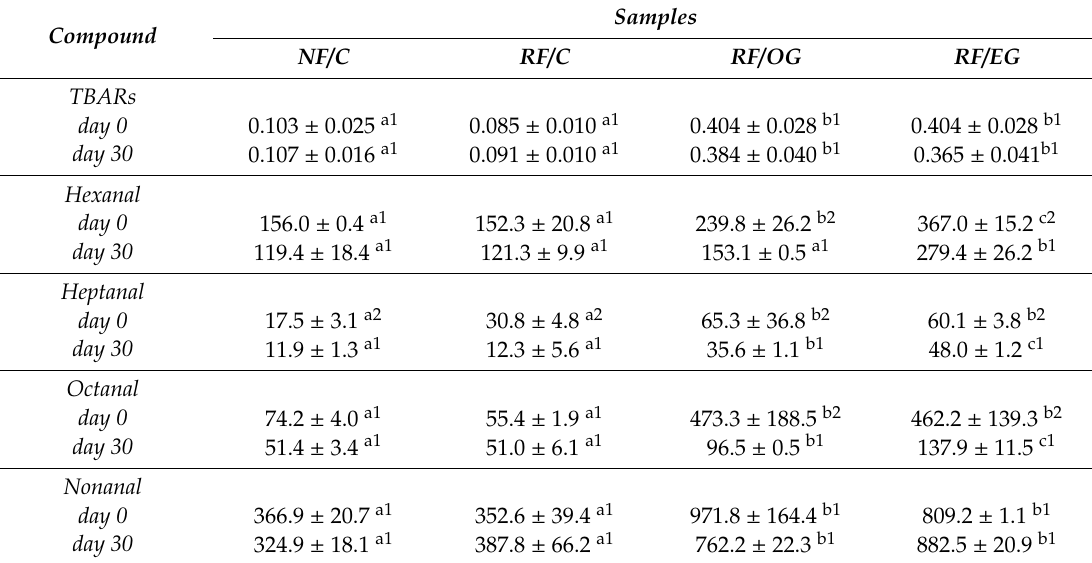
Table 5. Parameters related to lipid oxidation of fuets during chilled storage: thiobarbituric acid-reactive substances (TBARs) values (mg malonaldehyde (MDA) / kg sample) and volatile compounds (area / sample weight (g) × 10 3